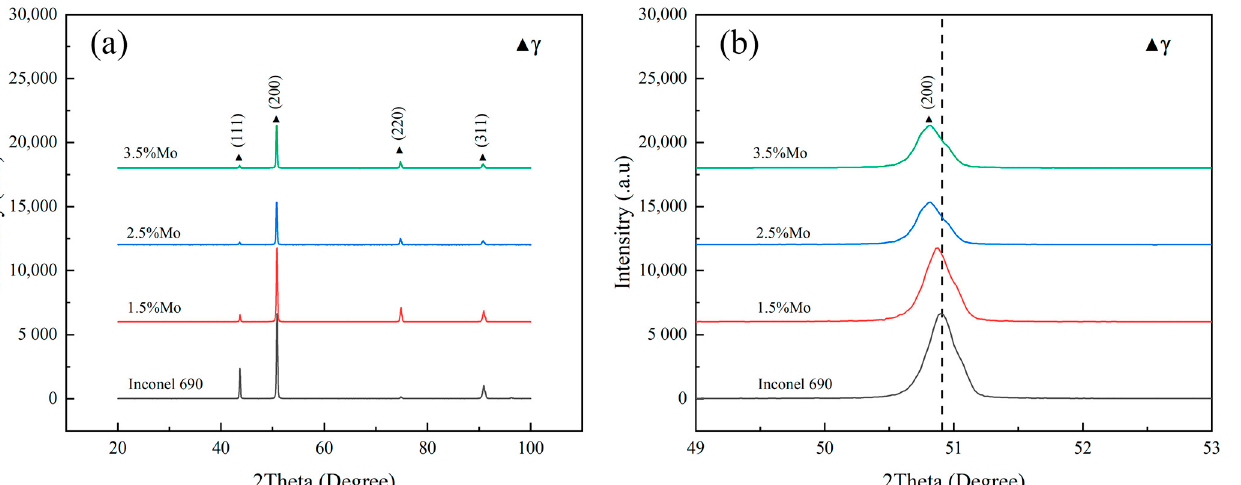
Figure 5. SEM micrographs and compositional analysis of M 23 C 6 : ( a ) M 23 C 6 precipitated on grains boundary; ( b ) EDS results of M 23 C 6 .